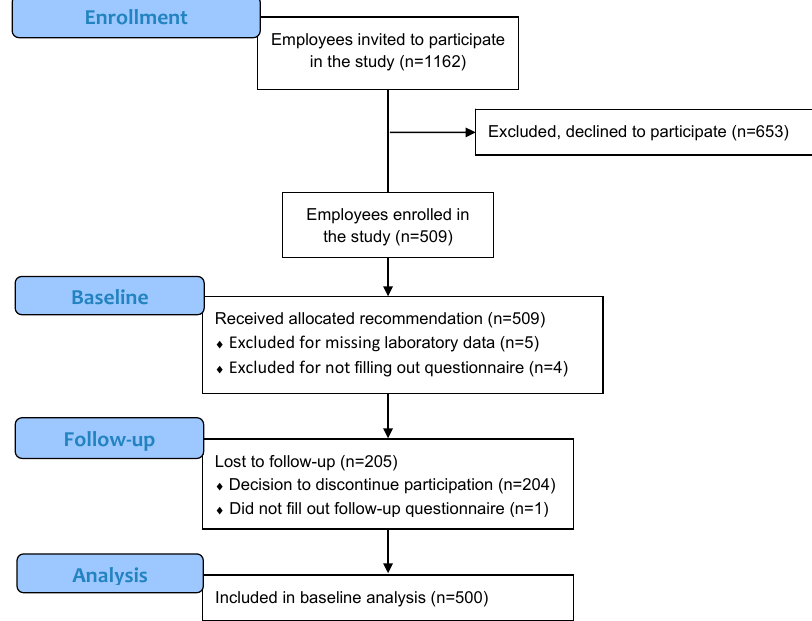
Figure 1. Flow diagram for study design and flow chart of recruitment, baseline (October to December 2017) and follow-up (March to April 2018) analysis.